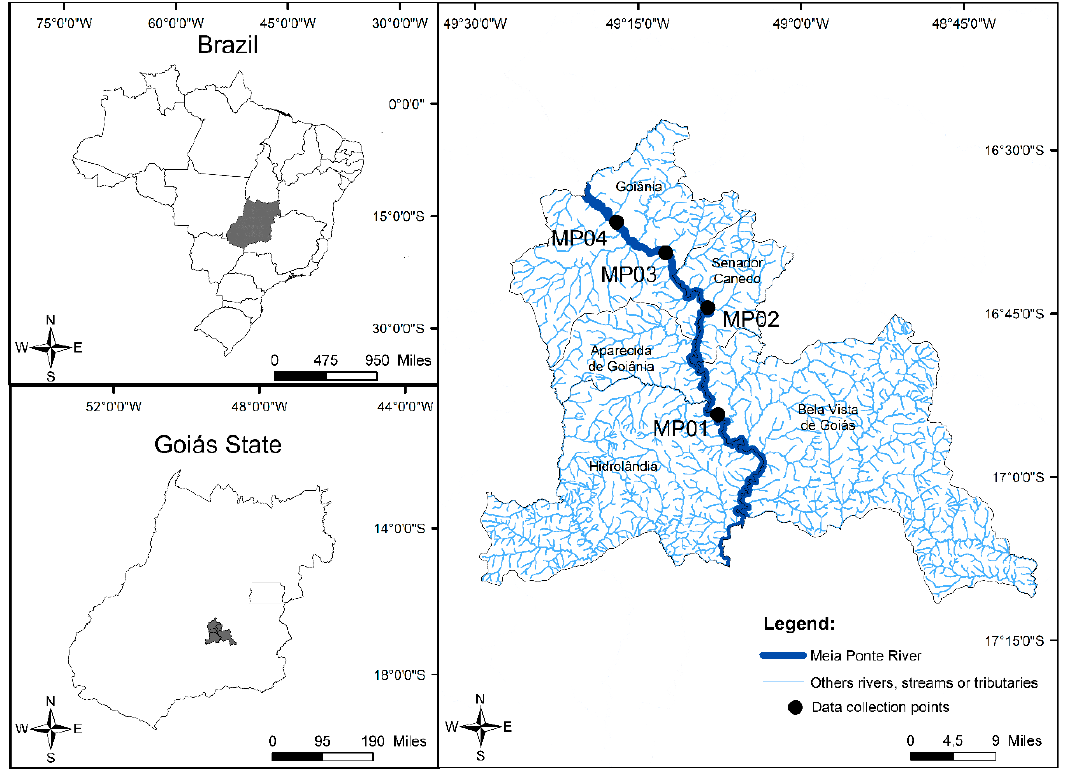
Figure 1. Map showing the sampling locations of water and sediment samples from the Meia Ponte River. The referred geographic coordinates of the sampling points are MP01 16 ◦ 54 (cid:48) 16.3 (cid:48)(cid:48) S; 49 ◦ 07 (cid:48) 37.8 (cid:48)(cid:48) W, MP02 16 ◦ 44 (cid:48) 27.7 (cid:48)(cid:48) S; 49 ◦ 08 (cid:48) 35.3 (cid:48)(cid:48) W, MP03 16 ◦ 39 (cid:48) 26.0 (cid:48)(cid:48) S; 49 ◦ 12 (cid:48) 27.1 (cid:48)(cid:48) W and